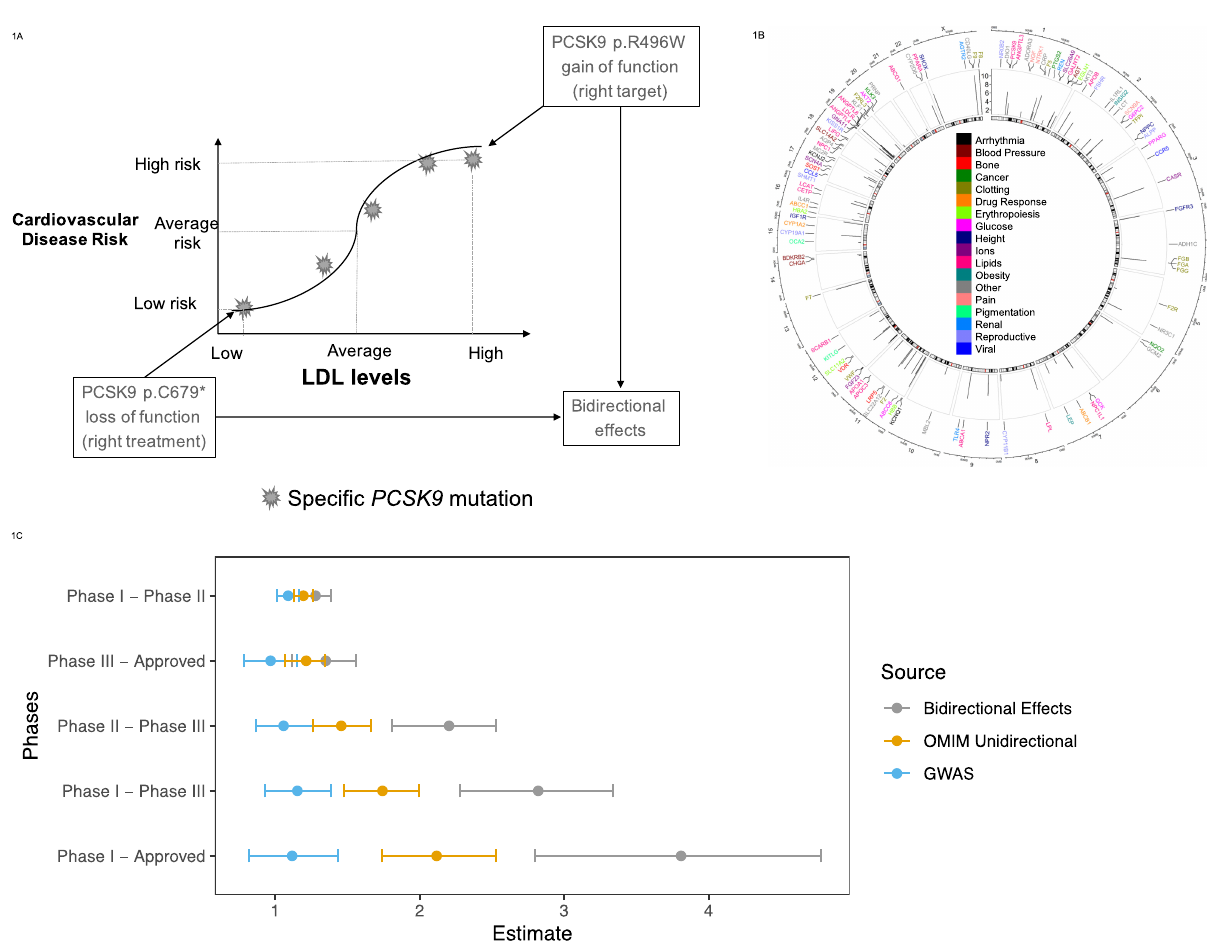
Fig. 1 Generalizability of bidirectional effects for increasing probability of success on clinical trials. A Graphical representation of a gene (PCSK9) showing bidirectional effects on LDL and cardiovascular disease risk. B Circos plot of 98 genes with bidirectional phenotypic effects. From outside to inside: all autosomes and the X chromosome are depicted in a clockwise orientation. The genomic coordinates are shown for each gene that was identi fi ed to contain different variants with phenotypically opposing HGMD annotations. The panels with radial lines display the total number of HGMD variant entries (log base 2) that were categorized as bidirectional, for each gene. Each gene label is color coded based on the phenotype that displayed bidirectionality. C Estimated odds ratio for transitions between various clinical trial phases. We calculated the odds ratio for transition and 95% con fi dence interval, for the subset of target-indications with genetic support from GWAS, OMIM associations with unidirectional effects, and bidirectional effects curated from HGMD. Measure of center for the error bars represent the estimated odds ratios and the error bars represent the 95% con fi dence intervals. Bidirectional effect supported data is shown in gray, OMIM unidirectional support is shown in orange, and GWAS support is shown in blue. n = 26,884 target- indication